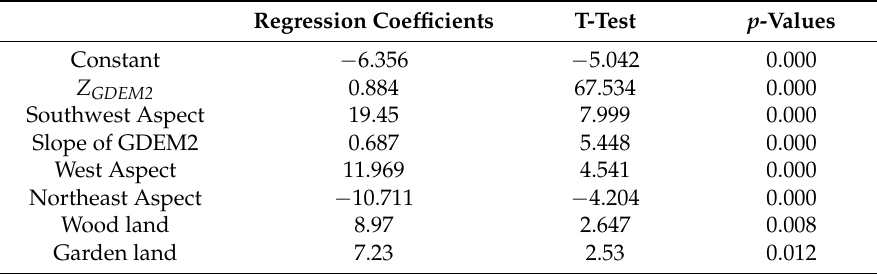
Table 4. The multiple linear regression model of Z elev